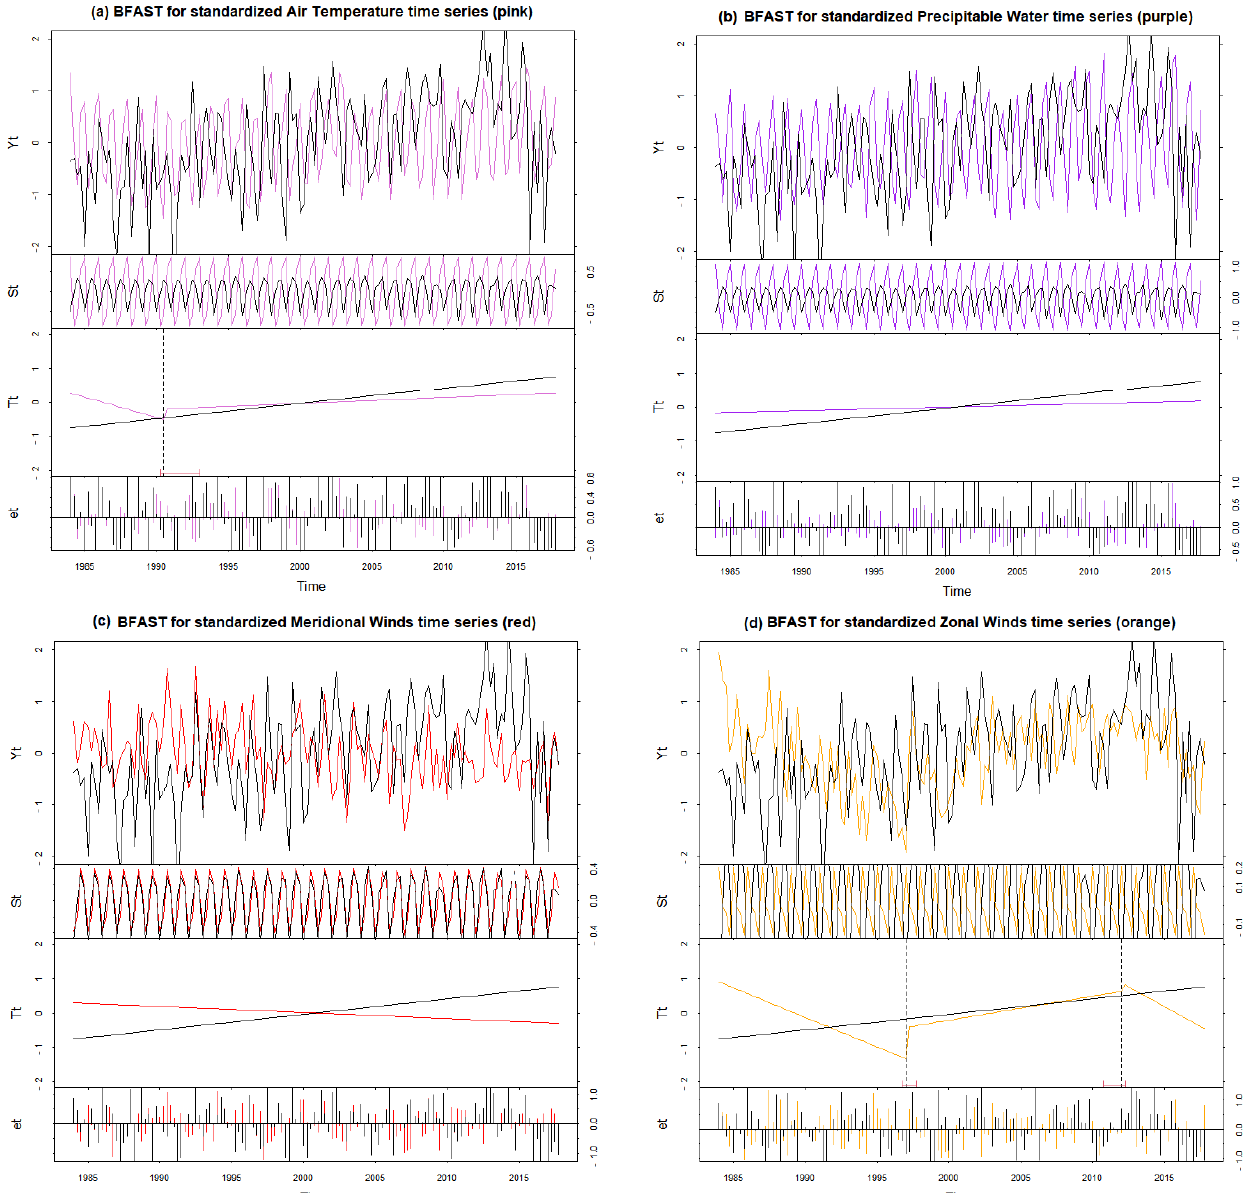
Figure 5. Reservoir NDVI time series ( Y (cid:2930) ) and its seasonality ( S (cid:2930) ) and trend ( T (cid:2930) ) components, resulting from the application of the BFAST (black lines), superimposed on the standardized time series of the climate variables: air temperature (( a ) pink); precipitable water (( b ) purple); meridional wind (( c ) red); and zonal wind (( d ) orange).